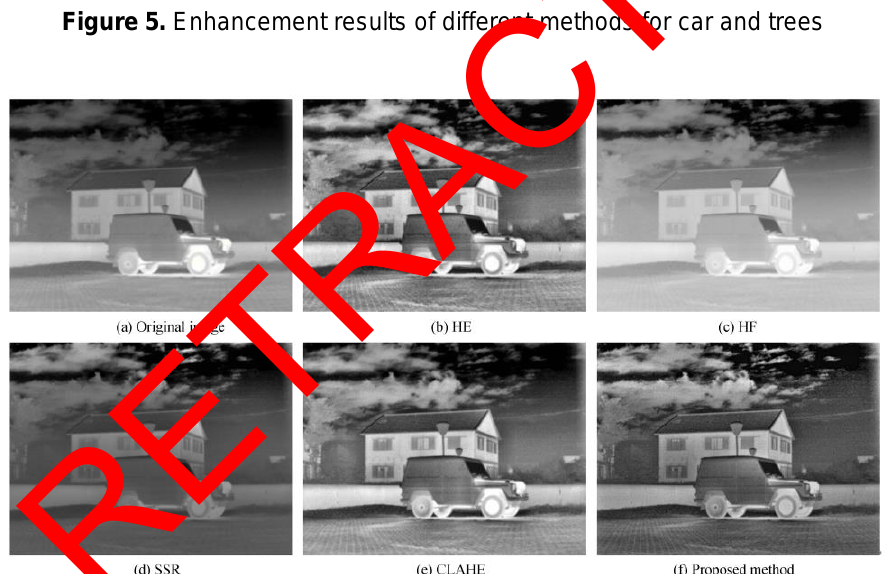
Figure 5. Enhancement results of different methods for car and trees